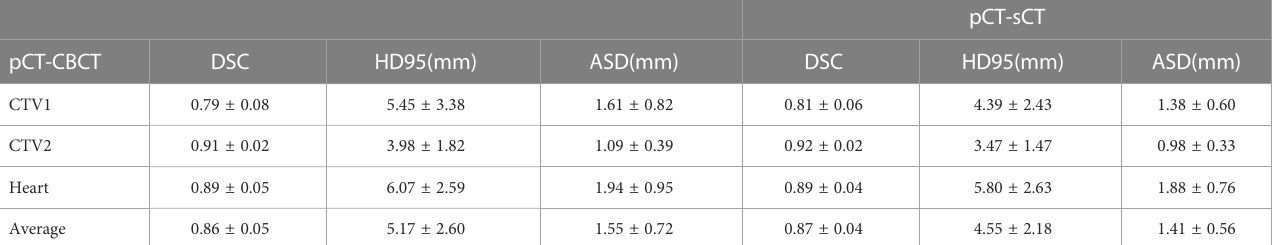
TABLE 1 The results of the Dice similarity coef fi cient (DSC), 95 percent Hausdorff distance (HD95), and average surface distance (ASD) on the various